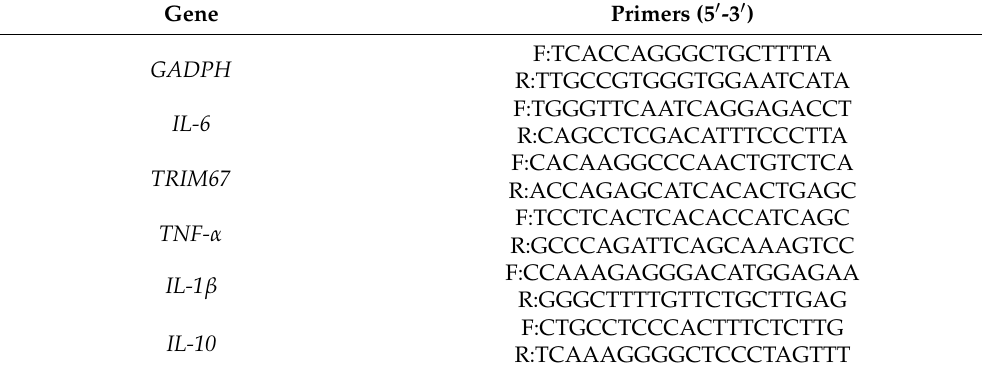
Table 2. qPCR primers for